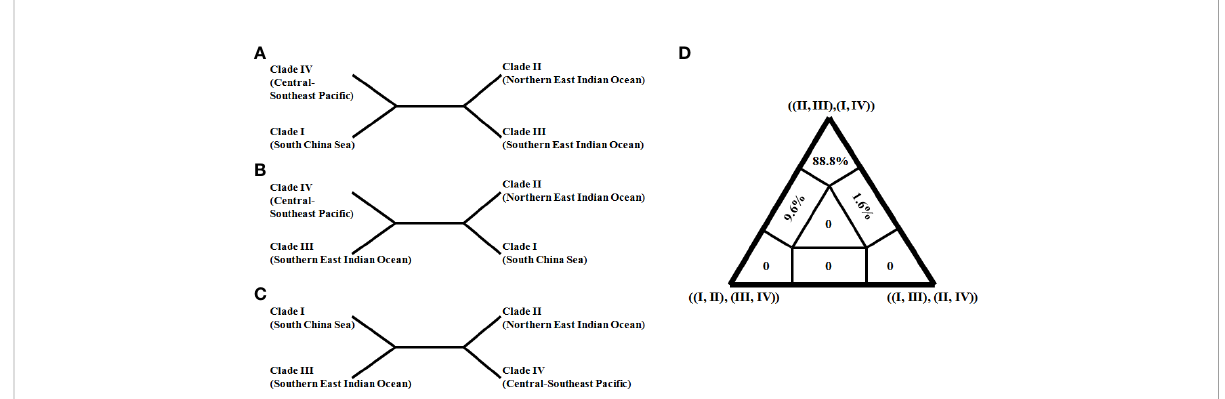
FIGURE 4 Three competing evolutionary relationships (A – C) among four clades (I – IV) of Sthenoteuthis oualaniensis and likely mapping triangle diagram (D) . The East Indian Ocean monophylitic combination of ((II, III) and (I, IV)) obtained the highest support probability